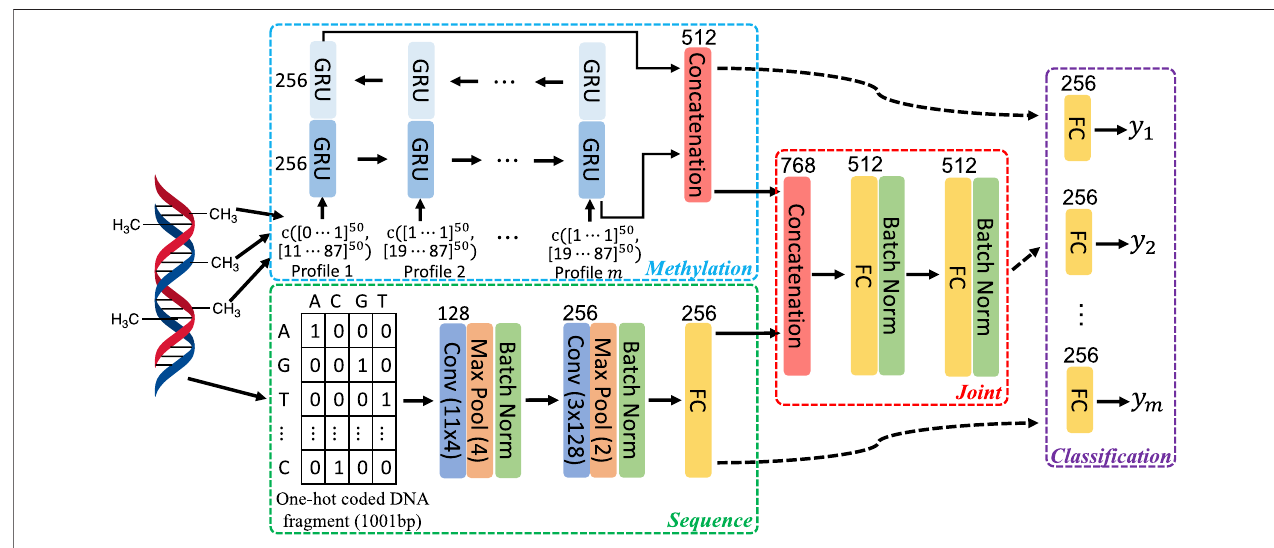
FIGURE 1 | Architecture of network components in our study. Each colored bar represents a layer of operation in the network as indicated by the enclosed description. The numbers on the top or the side of bars specify the number of fi lters or hidden units in the corresponding layers. Activation functions following convolutional or fully connected layers and that in GRU are not shown. The former uses recti fi ed linear function, while in the latter, hyperbolic tangent function is employed. [ d 1 / d 50 ] 50 represents a numerical vector of size of 50 and c ( v 1 , v 2 ) denotes the concatenation of two vectors: v 1 and v 2 . y i ’ s represent methylation state of the single CpG to predict in multiple pro fi les. When transferring trained models from source to target, components of Sequence, Methylation, Joint, or their combinationsaretransferred. Components thatarenottransferredaretrained fromscratch(i.e.,randominitialization).Conv, convolution; MaxPool,maxpooling;Batch Norm, batch normalization; FC, fully connected.